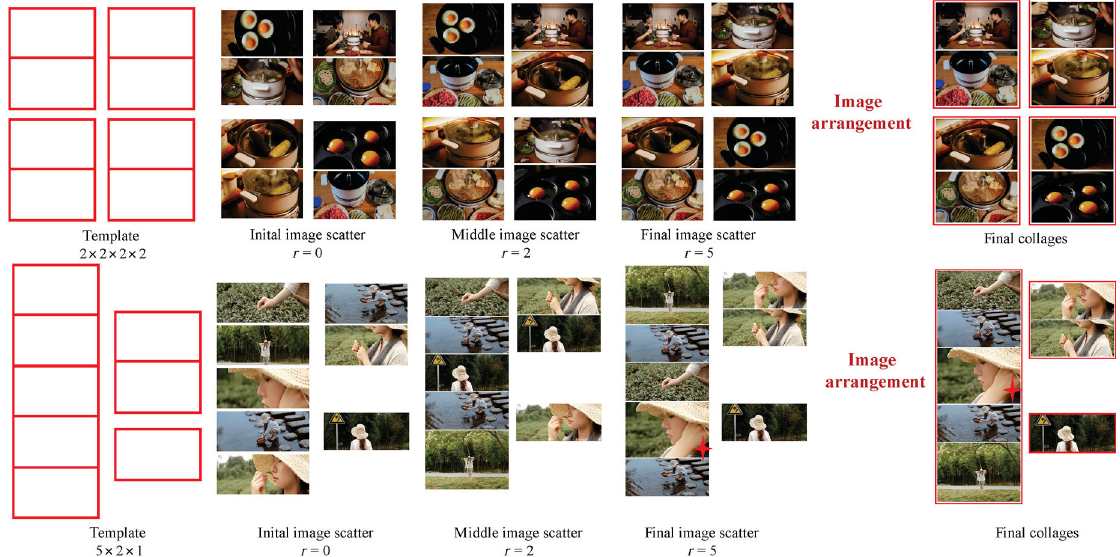
Fig. 5 Pipeline of template-fixed collage generation. The fixed template is sketched out with red boxes, and the uniqueness image is labeled with red star. As the number of iterations ( r ) increases, the collages gradually becomes clear and tidy information, which leads to a visually easy and pleasant